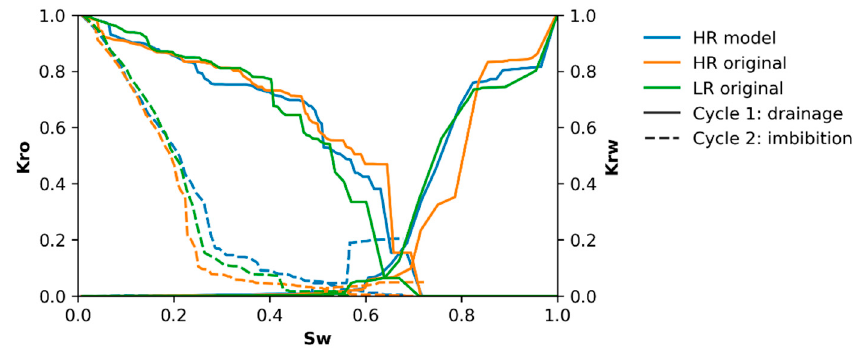
Figure 13. Impact of super-resolved models on relative permeability evolution of oil (K ro ) and water (K rw ) with varying water saturation (S w ) during oil-flooding (drainage) and water-flooding (imbibition). Table 7. Impact of super-resolution models on residual oil fraction and relative water permeability after waterflooding from two-phase oil-water fluid flow simulations on pore network models on four volumes of 500³ voxels each. Relative difference with expected high-resolution data is added. In the fourth volume, SRM relative water permeability appears severely overestimated.